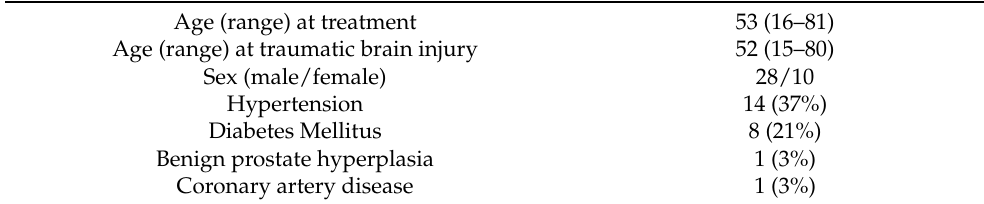
Table 1. Demographics of the chronic traumatic brain injury patients ( n =